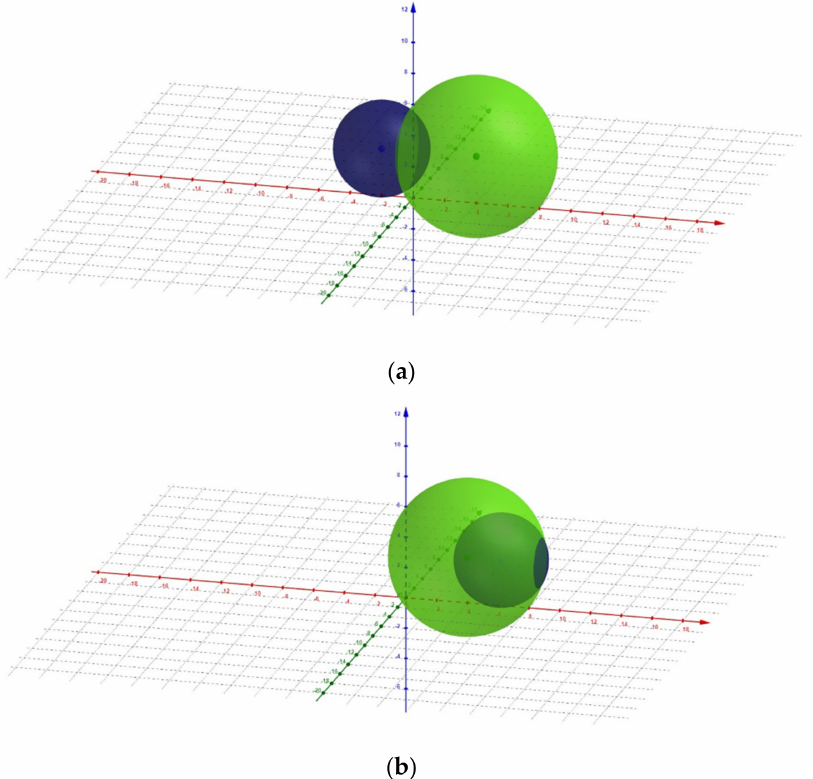
Figure 4. Simplified representation of the possible contact interactions between the two spheres: ( a ) external contact; ( b ) internal contact.